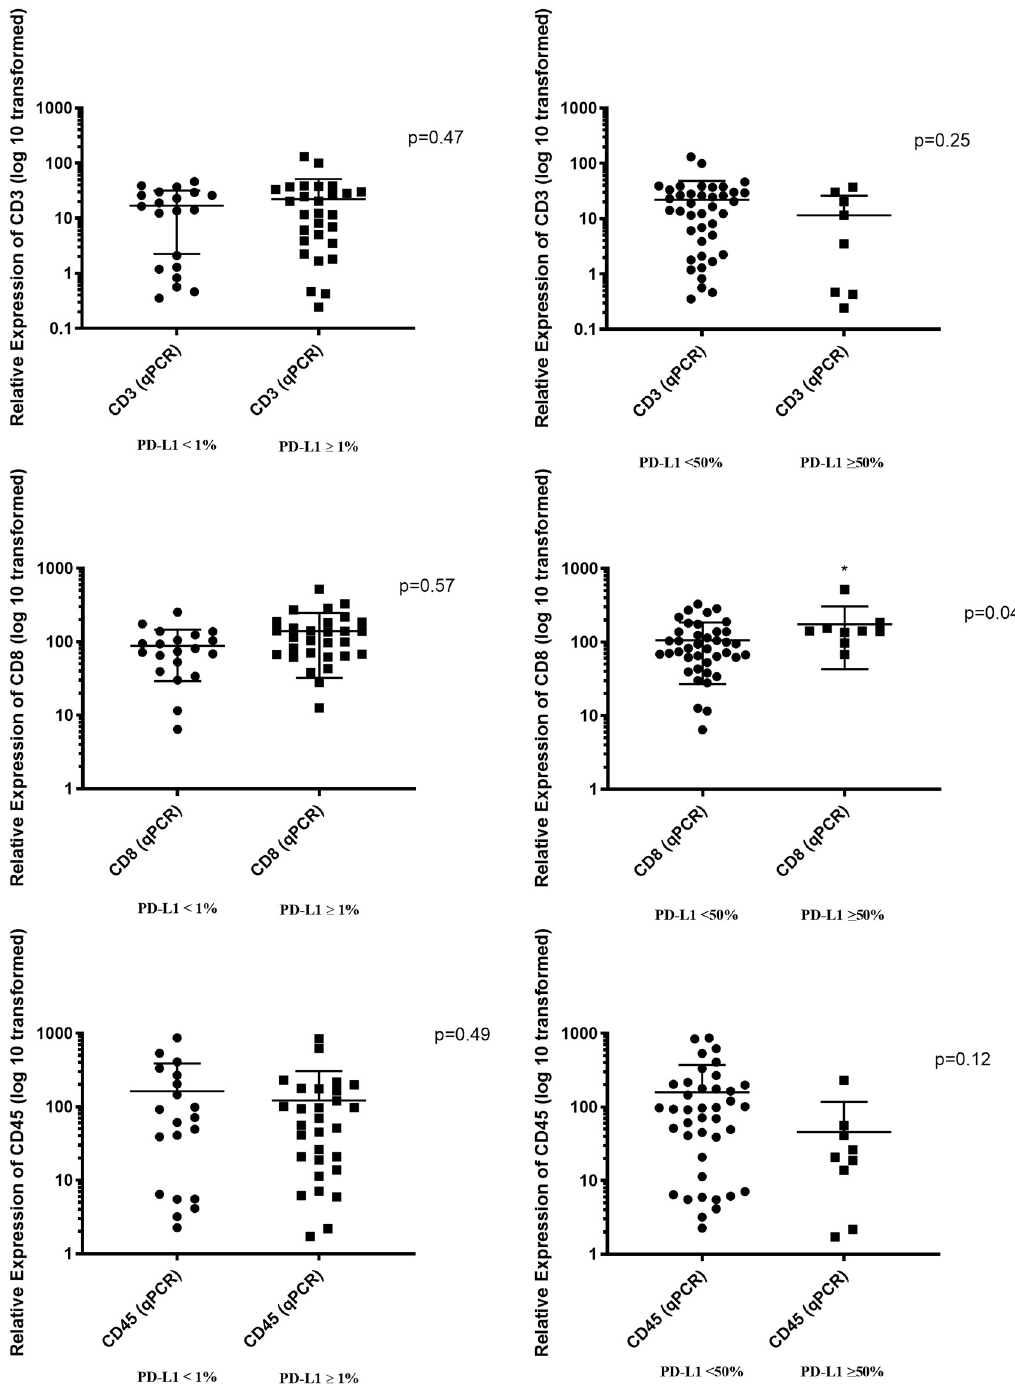
Fig 3. CD8 expression by qPCR correlates with PD-L1 expression by IHC for 50% cut-off. A total of 49 fresh lung tumors were evaluated for PD-L1 expression by IHC and quantified for CD8 , CD3 and CD45 mRNA by RT-qPCR. (A) CD45 (RT- qPCR) did not correlate with PD-L1 (IHC, 1% and 50% cut-off). (B) Also, CD3 marker (qPCR) was not significantly correlated with PD-L1 (IHC, 1% and 50% cut-off). (C) CD8 marker (RT-qPCR) was significantly correlated with PD-L1 (IHC) for 50% cut-off but not for 1%